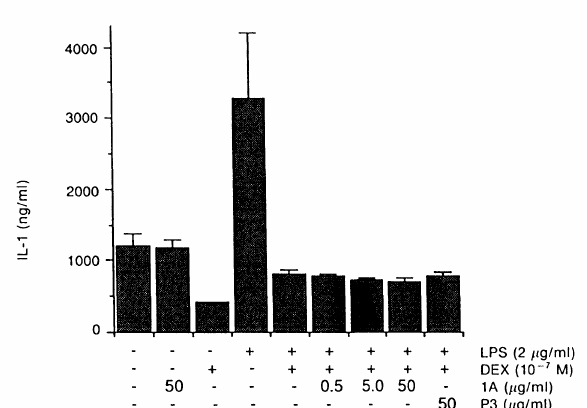
FIG. 1. Monocyte IL-lfl release: effects of neutralizing antibody to lipocortin 1. Peripheral blood monocytes were cultured for 48 h in the presence of bacterial lipopolysaccharide 2 #g/ml (LPS), dexamethasone 10 -7 M (DEX), anti-lipocortin antibody 0.5-50/g/ml (1A) and/or control antibody (P3), and the IL-lfl concentration in culture supernatants measured by ELISA. LPS induced a marked increase in IL-lfl release (p= 0.001) which was suppressed by dexamethasone (p= 0.009). Dexamethasone also inhibited resting (non-LPS-treated) monocyte IL-lfl release (p= 0.009). Anti-lipocortin antibody had no effect on the ability of DEX to suppress this response.